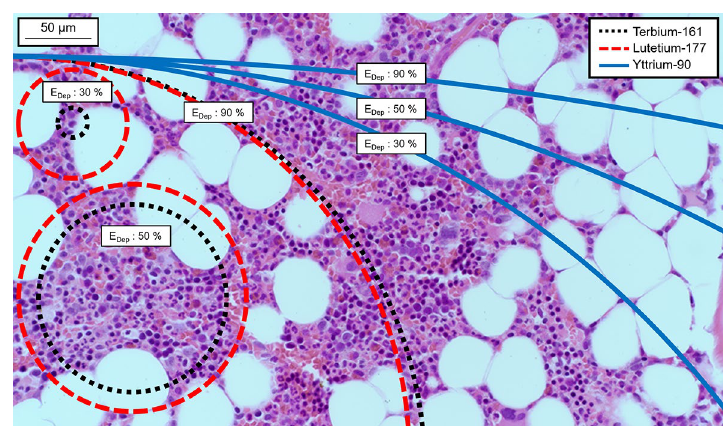
Fig. 6 A perspective of the range of energy deposition from a point source on a healthy spongiosa biopsy. 30%, 50%, and 90% of the total emitted electron energy from each of the three radionuclides are deposited within the respective black (terbium-161), red (lutetium-177), and blue circles (yttrium-90). The high energy and long range of yttrium-90 β -particles lead to circles with comparatively large